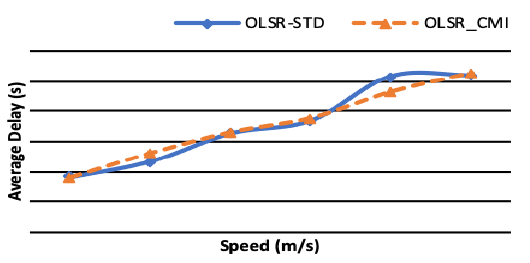
Fig. 7. Average Delay depending on the nodes speed